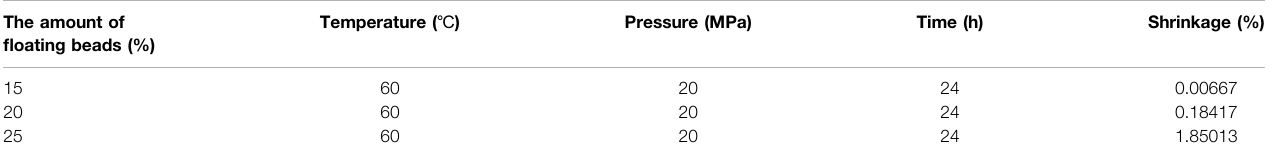
TABLE 5 | Test parameters and results of the volume shrinkage of cement stones. The amount of fl oating beads (%)